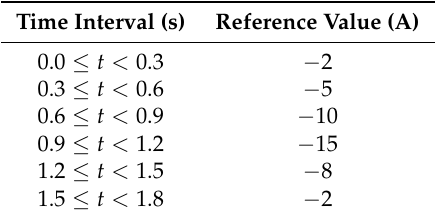
throughout the time of the simulation V2G b